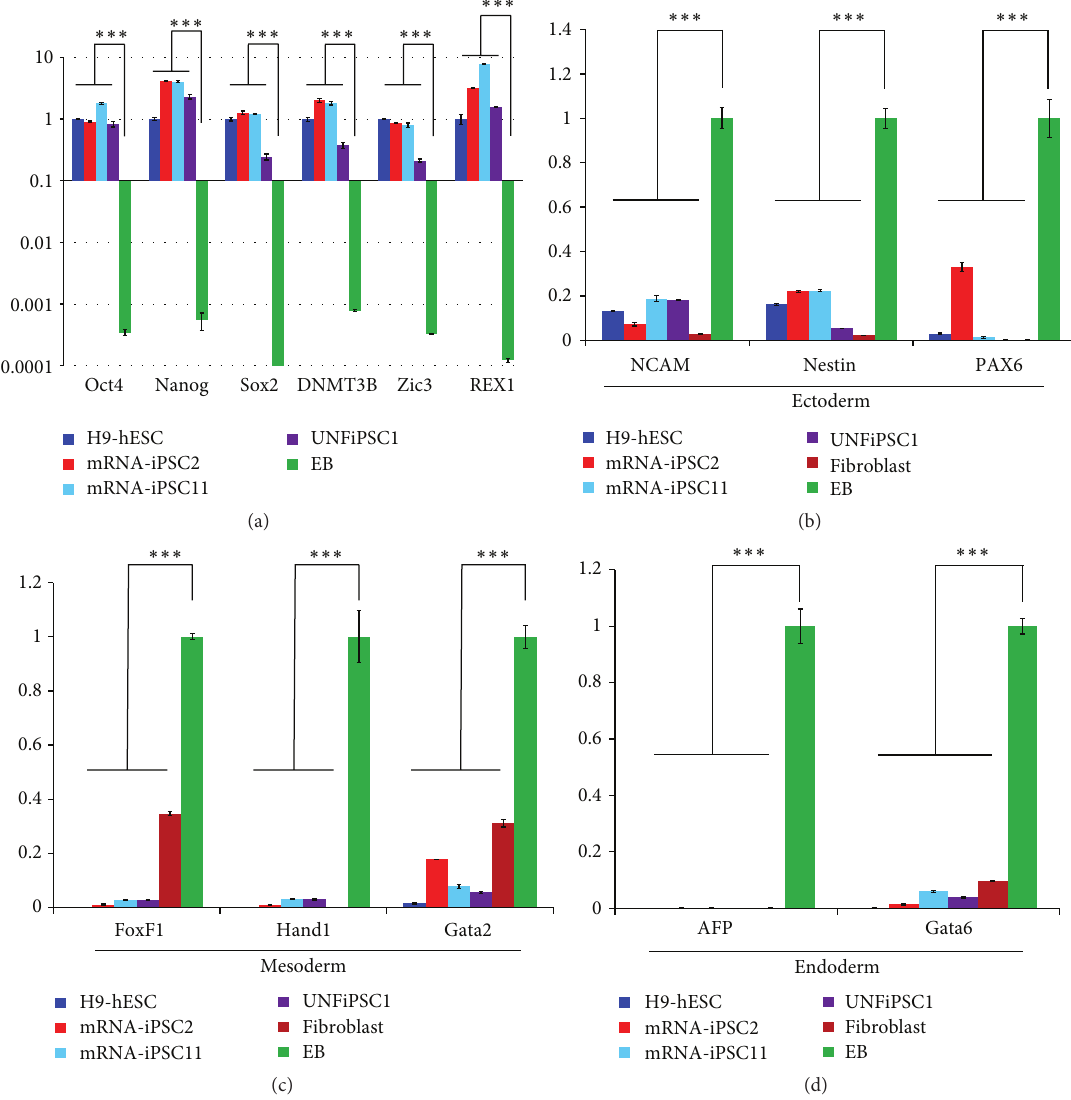
Figure 3: qRT-PCR analyses of the iPS cells. (a) The mRNA-iPSCs were analyzed for the expression of multiple representative lineage-specific markers.H9-hESCsandurine-derivediPScellsgeneratedusingtheepisomalplasmidmethod(UNFiPSC1)[18]wereusedaspositivecontrols, and EBs were used as negative controls. ∗∗∗ 𝑝 < 0.01 . (b–d) The expression levels of representative markers of derivatives of ectoderm (NCAM, Nestin, and Pax6) (b), mesoderm (FoxF1, Hand1, and Gata2) (c), and endoderm (AFP and GATA6) (d) were examined via qRT-PCR. In these experiments, H9-hESCs and UNFiPSC1 were used as controls for undifferentiated cells, whereas EBs and fibroblasts were used as controls for differentiated cells. ∗∗∗ 𝑝 < 0.01